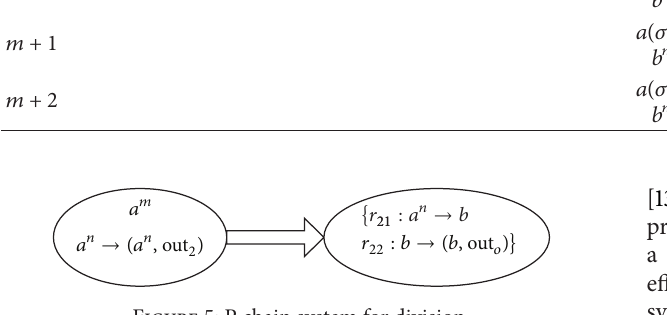
Figure 5: P chain system for